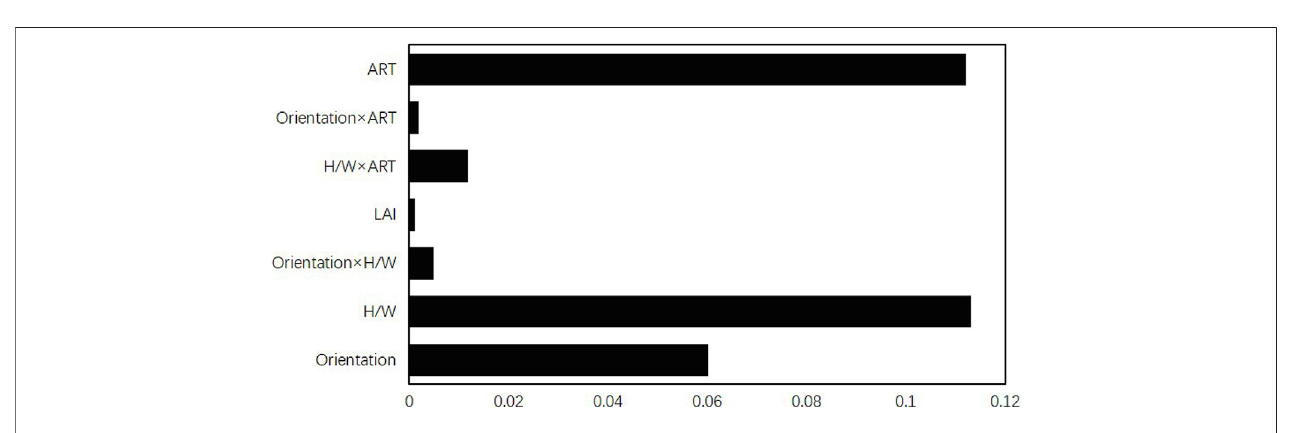
FIGURE 15 | Contribution rate of each factor and factor interactions.